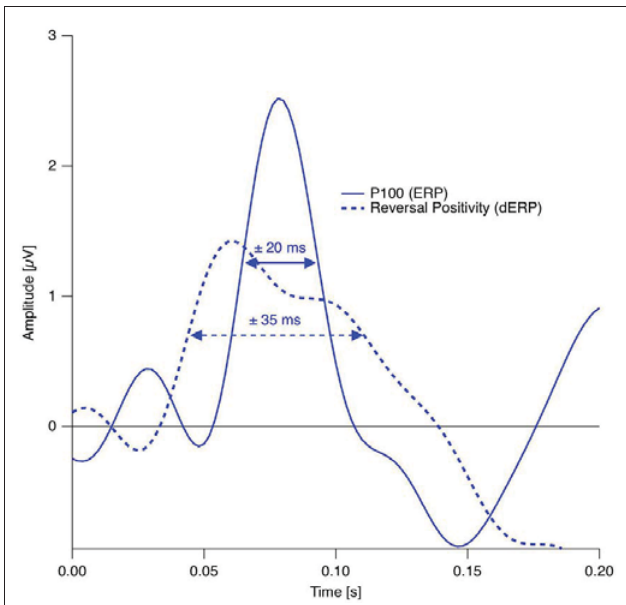
FIGURE 7 | Estimation of the temporal precision with the Onset Paradigm. Continuous trace: Grand mean ERP trace from the occipital electrode in the reversal condition in the P100 time window. Dotted trace: Grand Mean dERP trace from the occipital electrode position in the time window of the RP.The dERP trace is shifted on the time scale in order to align the RP with the P100 and thus to simplify peak-with comparison. Data from Kornmeier and Bach (2005).